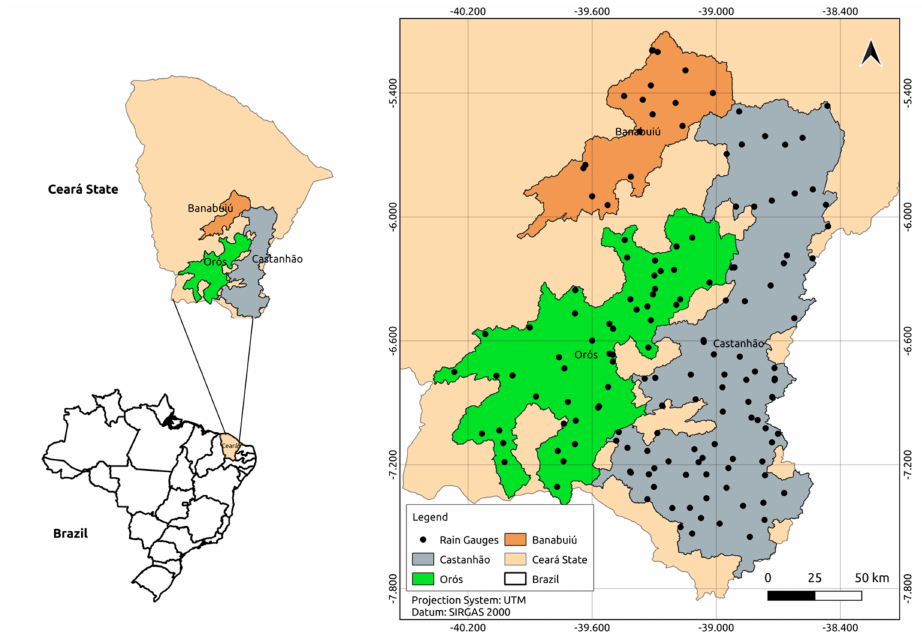
Figure 2. Study basins and location of rain gauges. Number of rain gauges in the Banabui ú , Castanh ã o, and Or ó s basin are 17, 83, and 50,